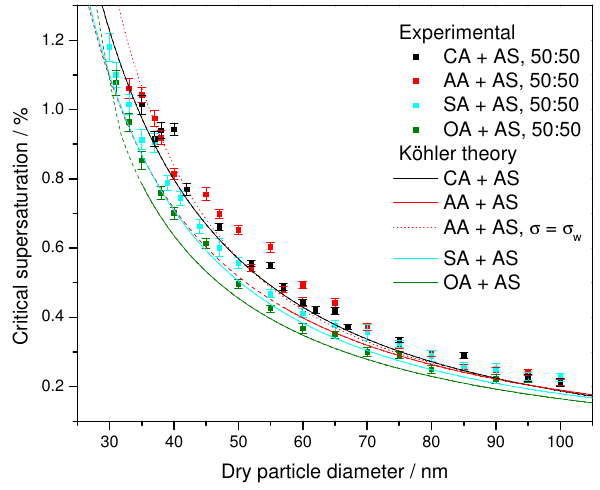
Fig. 8. Comparison between critical supersaturation measured with CCNC and calculated K¨ohler theory based on measured water activ- ity and surface tension for the 50:50 mixtures containing the slightly surface active organic compounds and ammonium sulphate (abbre- viations are explained in Table 1). The dashed sections indicate that the parameterizations of water activity and/or surface tension are based on extrapolation.